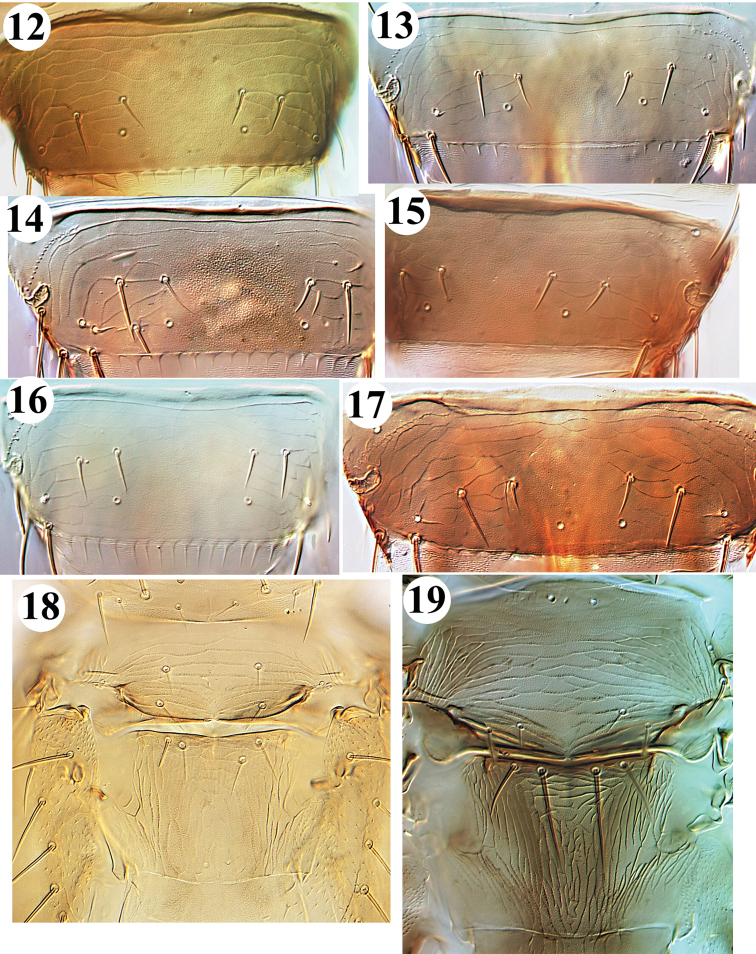
Frankliniella from China. Tergite VIII: 12intonsa13cephalica14occidentalis15schultzei16williamsi17tenuicornis. Meso- & metanotum: 18lilivora19tenuicornis.